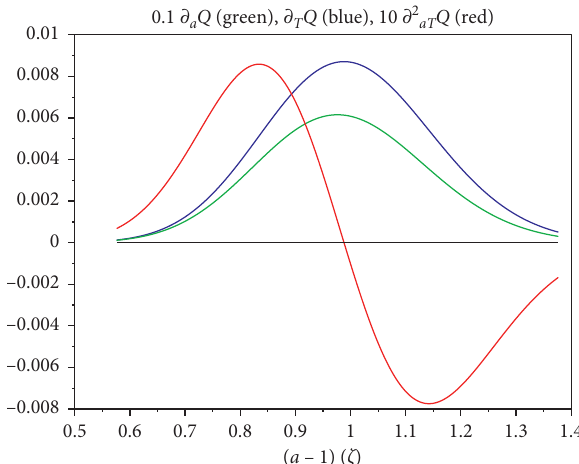
Figure 8: Plots of z (( a − 1 ) / ζ )